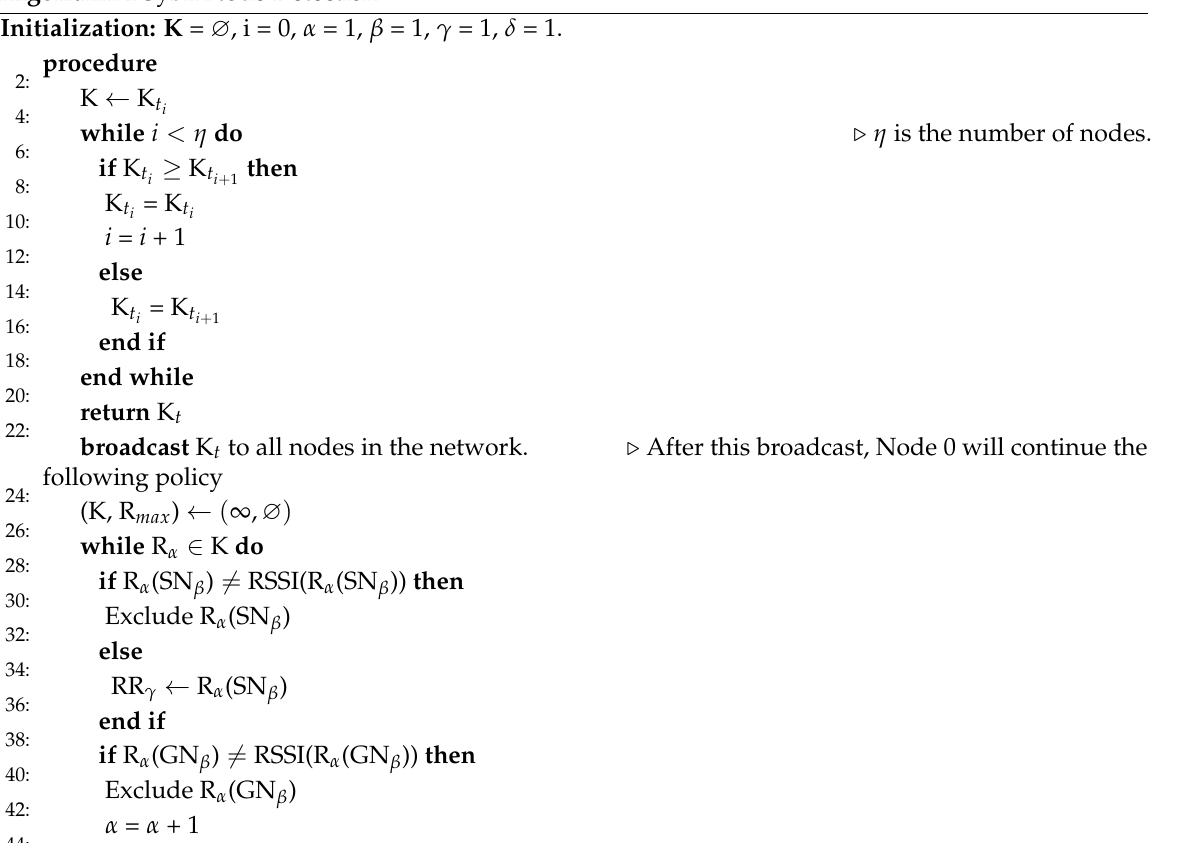
Algorithm 1 Sybil Node